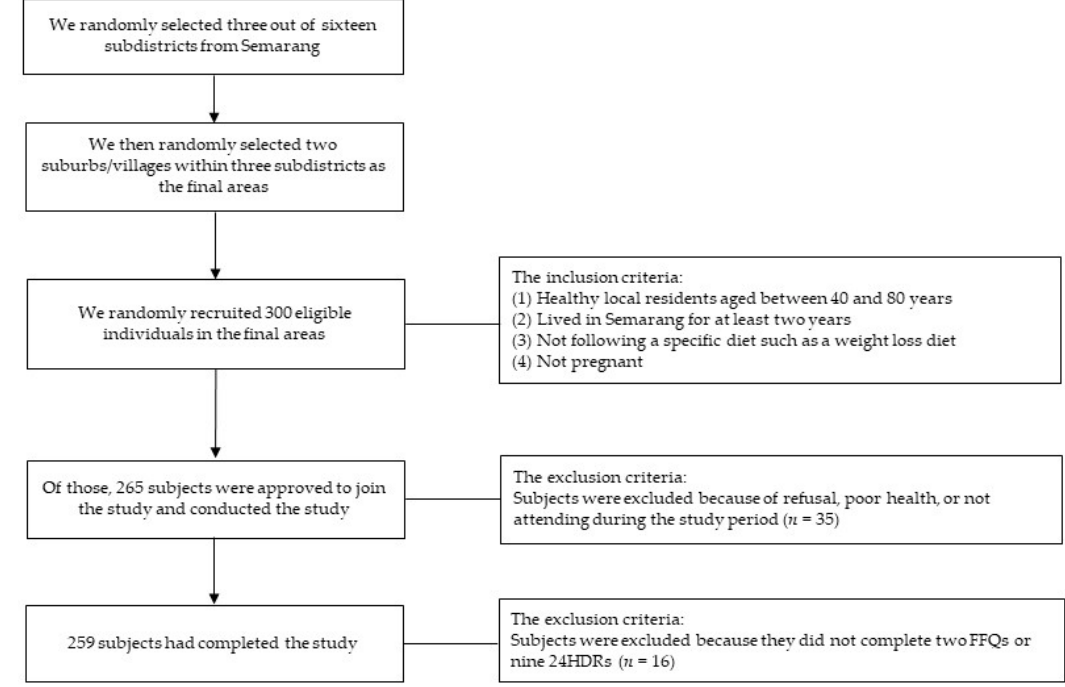
Figure 1. Flow diagram of subject recruitment.